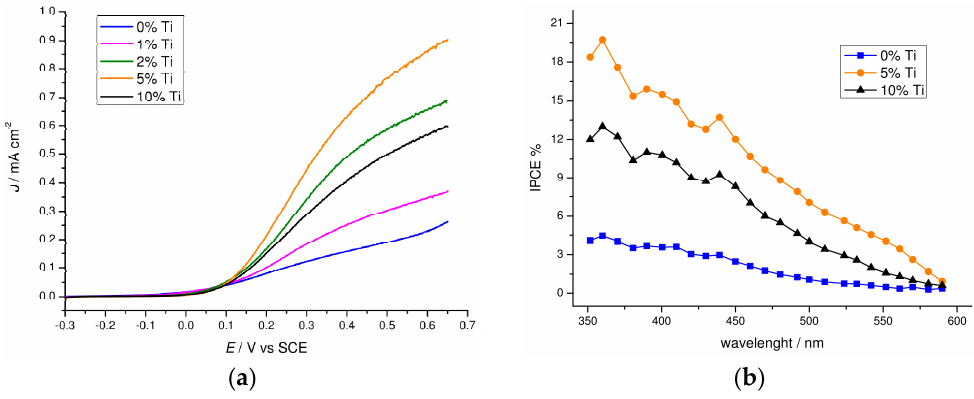
Figure 6. Photoelectrochemical measurements on Ti-modified hematite thin films. ( a ) J–V response of un-modified and Ti(IV)-modified hematite samples under AM 1.5G illumination (100 mW ⋅ cm − 2 ) in NaOH 0.1 M. Nominal titanium concentrations are reported in the legend. ( b ) IPCE spectra of un-modified (0%) and 5% and 10% Ti-modified hematite electrodes recorded at 0.6 V vs. SCE in 0.1 M NaOH (pH 13.3).